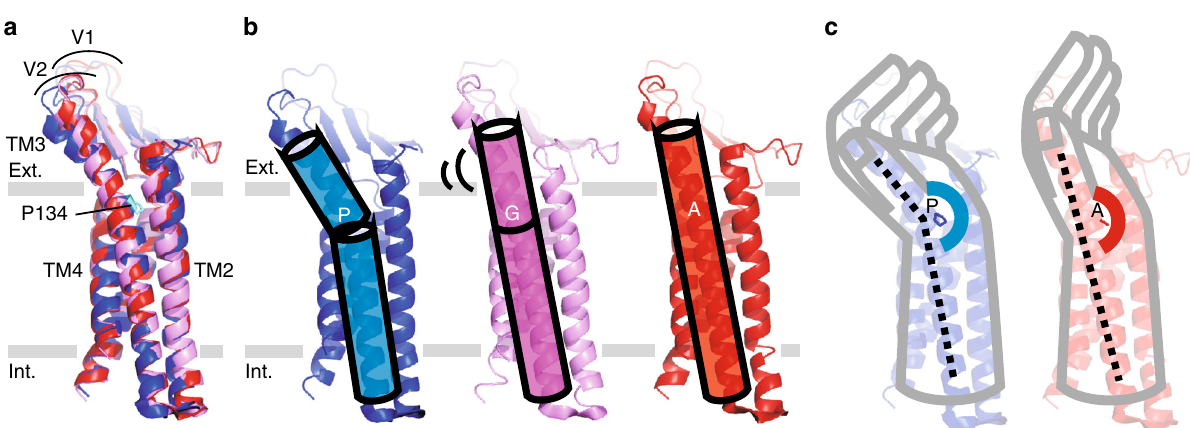
Fig. 3 Structures of Pro134 mutants. a Superposition of mCldn3 cryst (blue), mCldn3 cryst P134G (violet), and mCldn3 cryst P134A (red). C-CPEs paired with mCldn3 cryst , mCldn3 cryst P134G, and mCldn3 cryst P134A are omitted. b Determination of the TM3 structure with proline, glycine, or alanine. TM3 is bent in the case of proline (blue). TM3 is straight in the case of glycine, with probable swaying (violet). TM3 is straight in the case of alanine (red). c TM3 thenar in the left-hand model. The TM3 thenar is highlighted by the colored arc. When the TM3 thenar is proline, the bent TM3 makes the hand of the ECD lean toward the back of the hand (left). When the TM3 thenar is alanine, the straightened TM3 leads the hand of the ECD to align with the forearm of the TMD mCldn3 cryst P134G (Supplementary Figure 2h). In a crystal